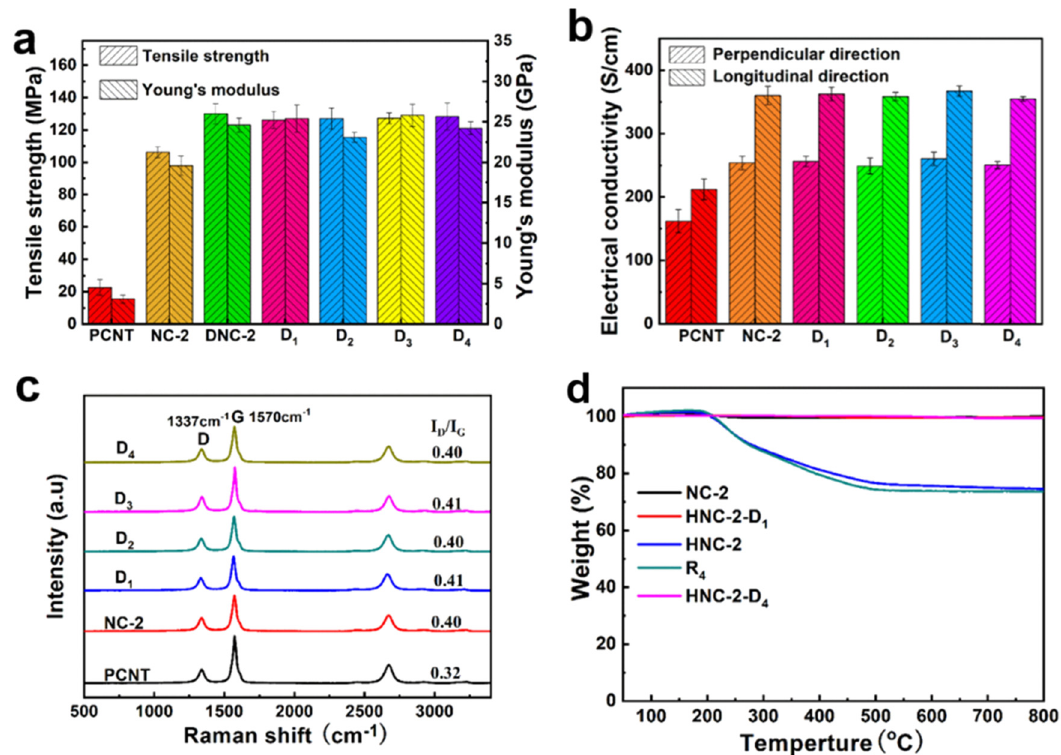
Figure 9: Properties of recycled in situ nitrogen doped CNT fi lm: ( a ) the strength of CNT fi lms, ( b ) electrical conductivity of CNT fi lms, ( c ) Raman spectra of recycled NC - 2 fi lms, and ( d ) TGA curves of treated CNT fi